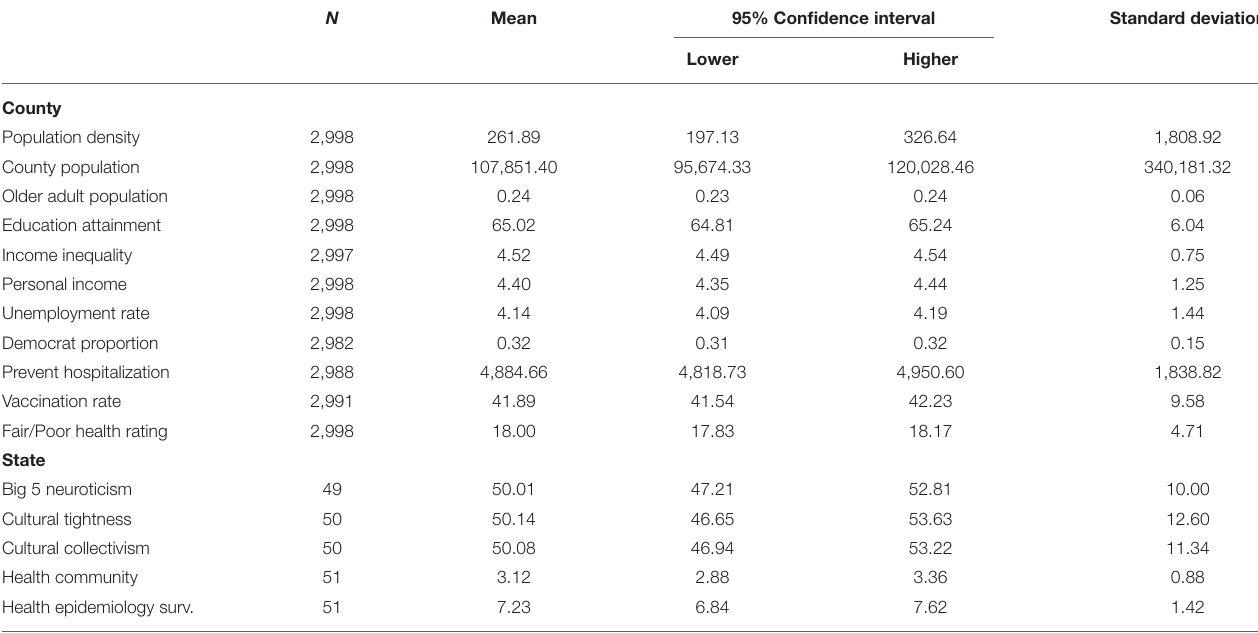
TABLE 1 | Descriptive statistics for time-invariant variables. N Mean 95% Confidence interval Standard